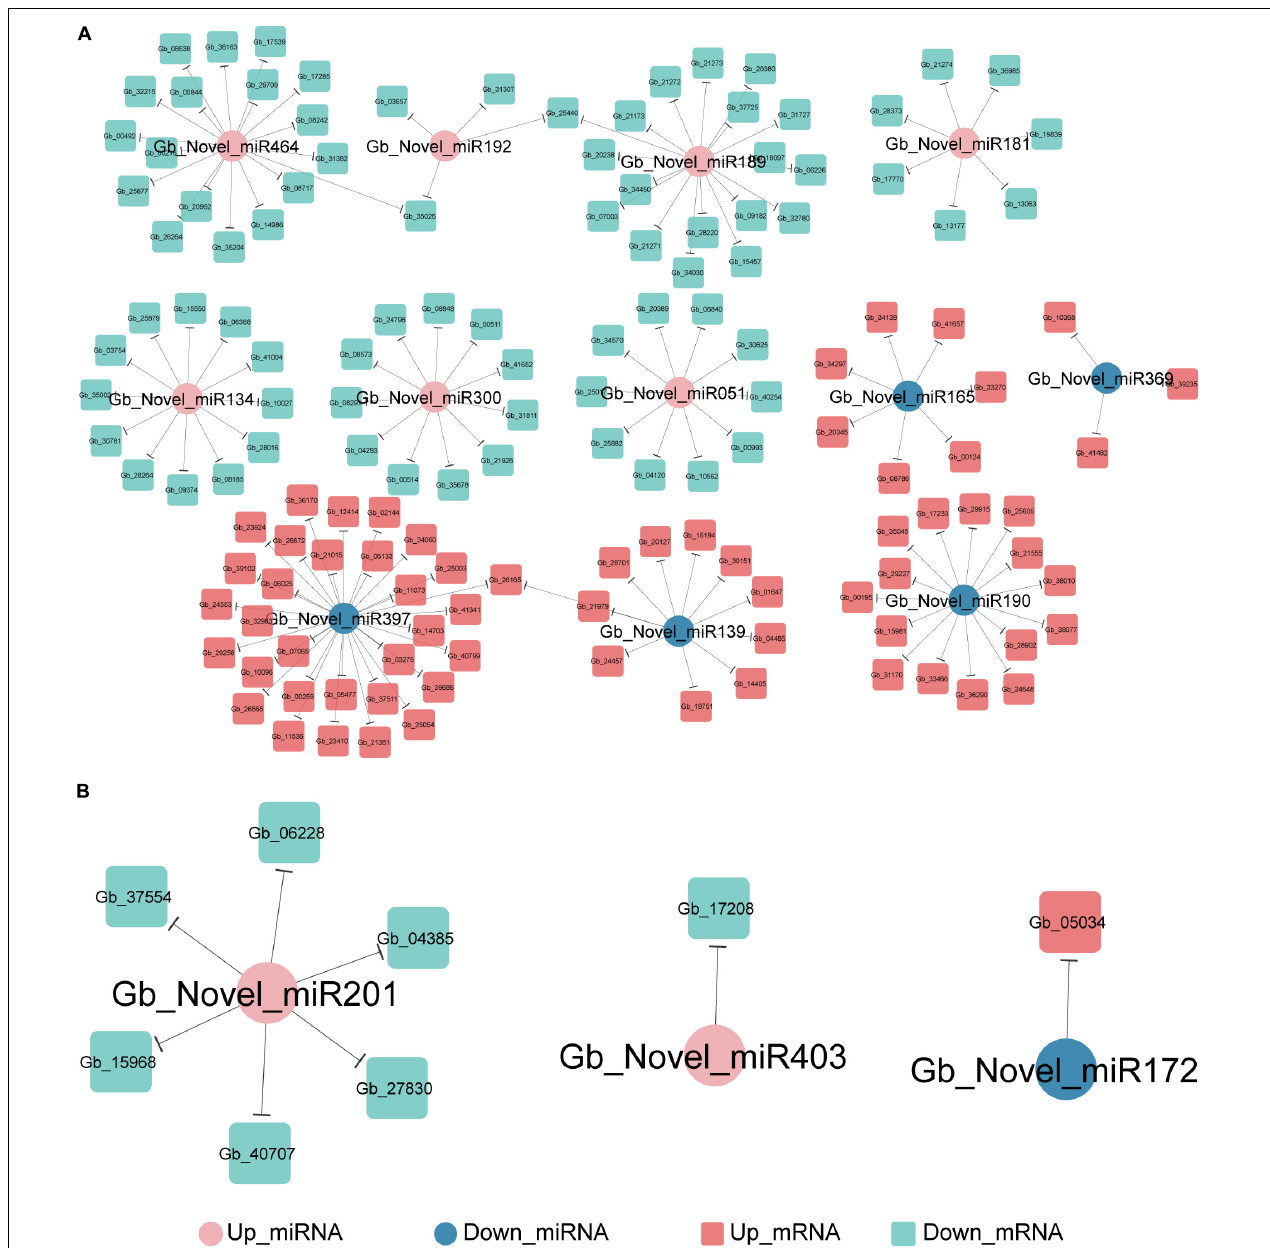
FIGURE 6 | The miRNA-mRNA regulatory networks during the initiation and enlargement of ovulate stalk primordia in ginkgo. (A) The target of genes of differentially expressed miRNAs (DEmiRNAs) between the initial differentiation (ST2) and the early exuberant differentiation stages (ST3-1). (B) The target of genes of differentially expressed miRNAs (DEmiRNAs) between the early (ST3-1) and the late (ST3-2) exuberant differentiation